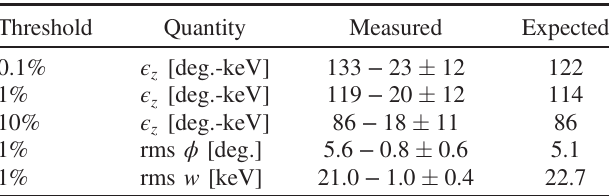
TABLE VII. Comparison of simulated (expected values) and measured emittances for partially projected phase space ˆ f ð ϕ ; w Þj ˜ y 2 ¼ 0 . The slice applied to the simulated (expected) distribution is comparable to BSM wire width.